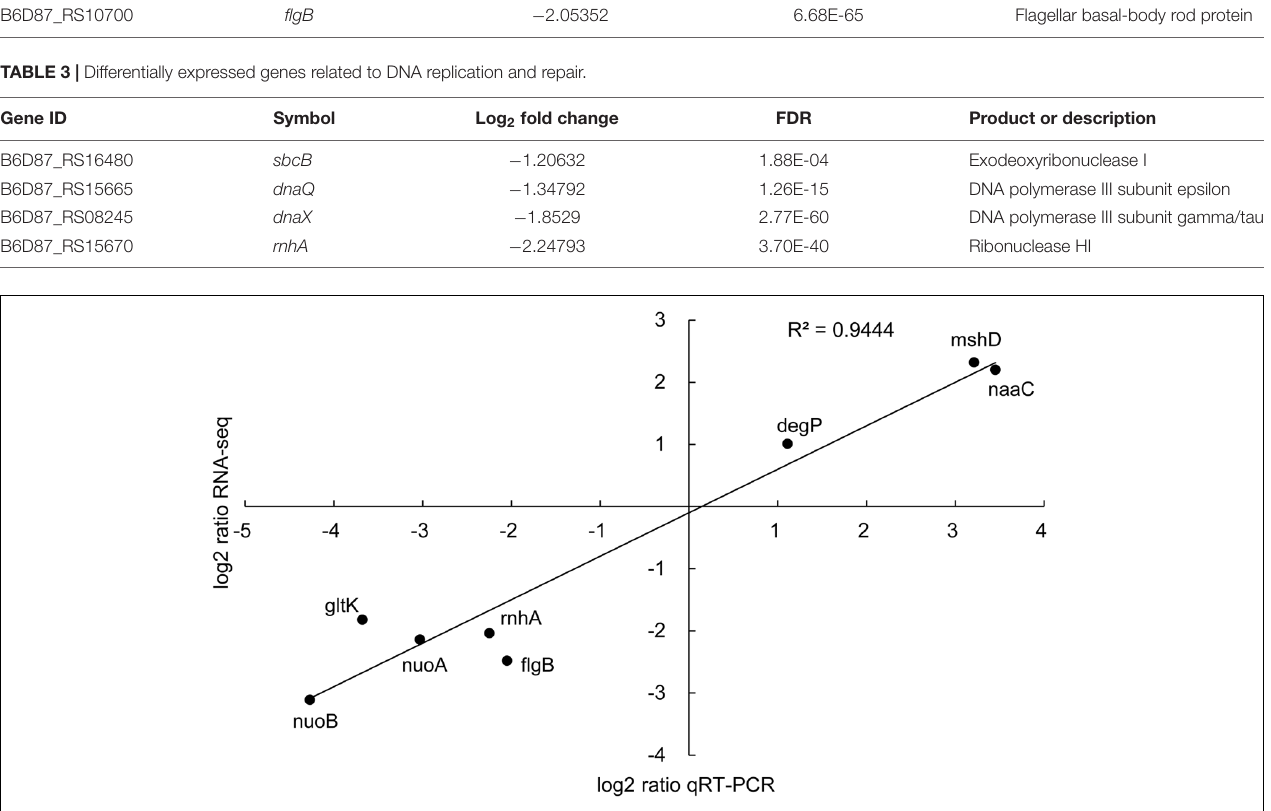
FIGURE 4 | Correlation of gene expression patterns of RNA-seq and qRT-PCR for nine selected